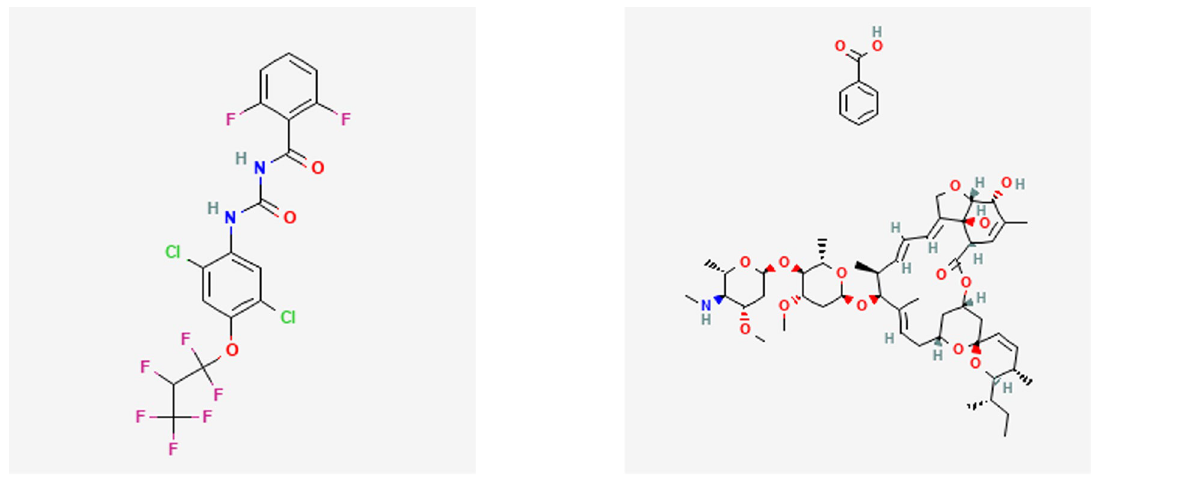
Table 1 Molecular structure of Lufenuron and Emamectin